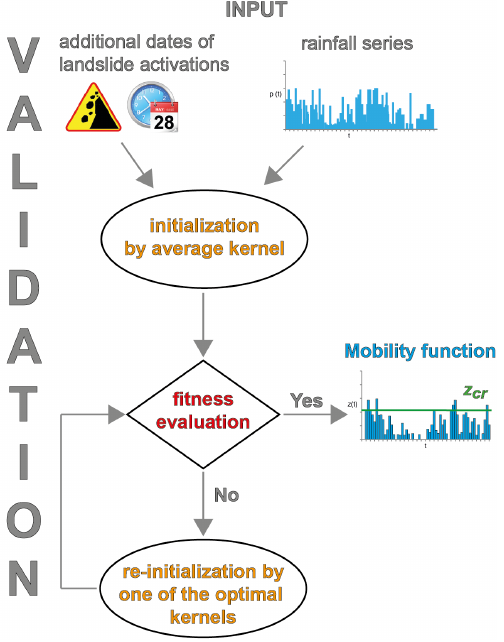
Figure 5. Scheme of the validation procedure of the GA SAKe